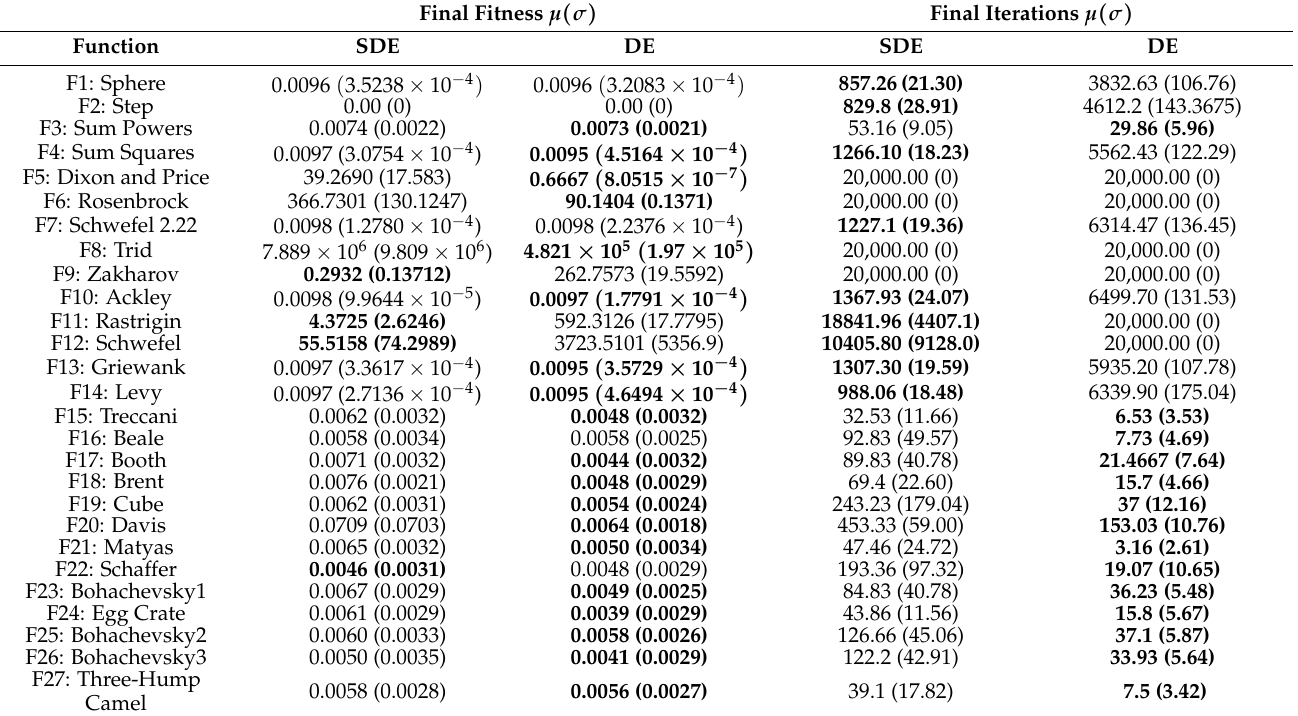
Table 7. Mean and averaged final fitness and iterations of DE and SDE ( N p = 256; D = 100). Final Fitness µ ( σ